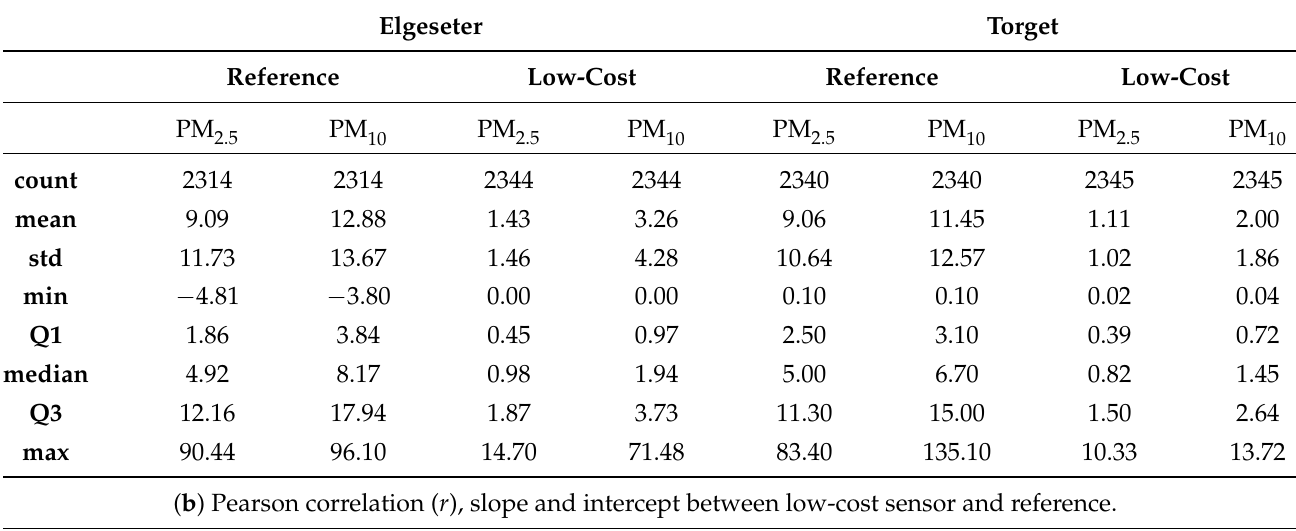
Table 2. Data collected between 15 November 2020 and 23 February 2021 for reference and low-cost sensors at locations where both are co-located. Data were not pre-processed and we used reference data “as is” from public API; therefore we maintained negative values that might be explained by the calibration procedures for industrial reference